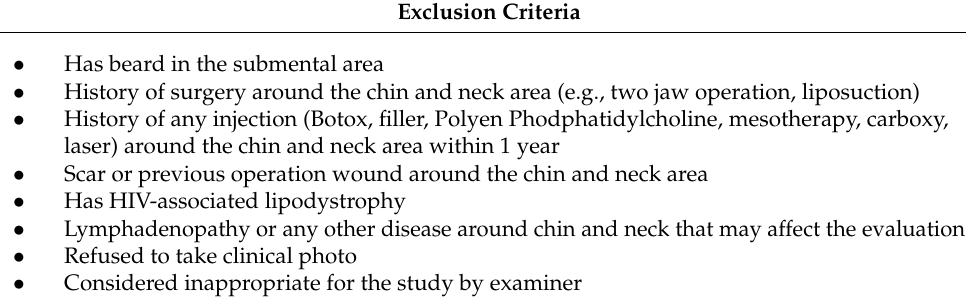
Table 1. Exclusion